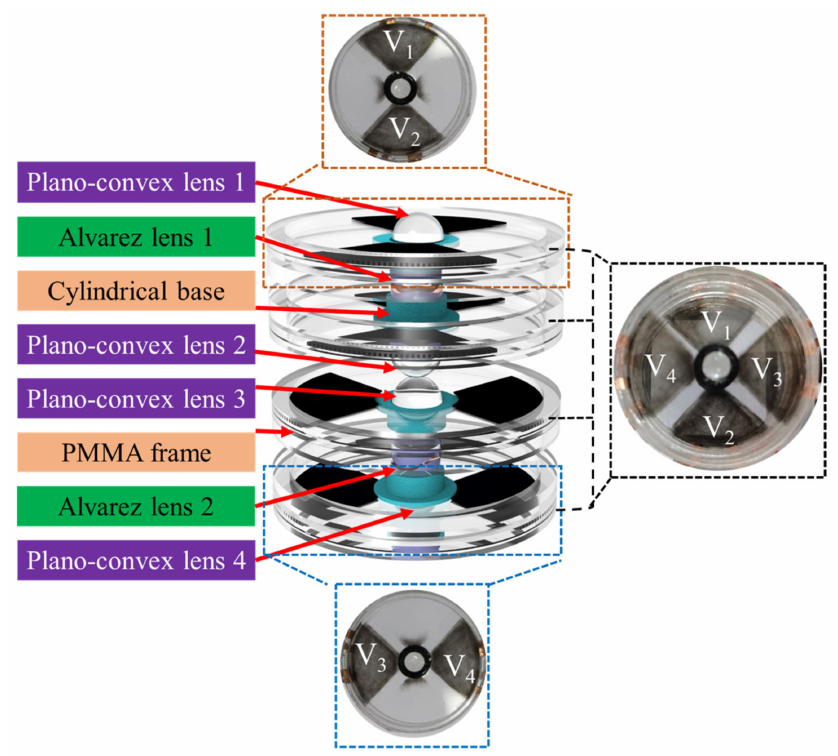
Figure 4. The structure and fabrication of the varifocal scanning